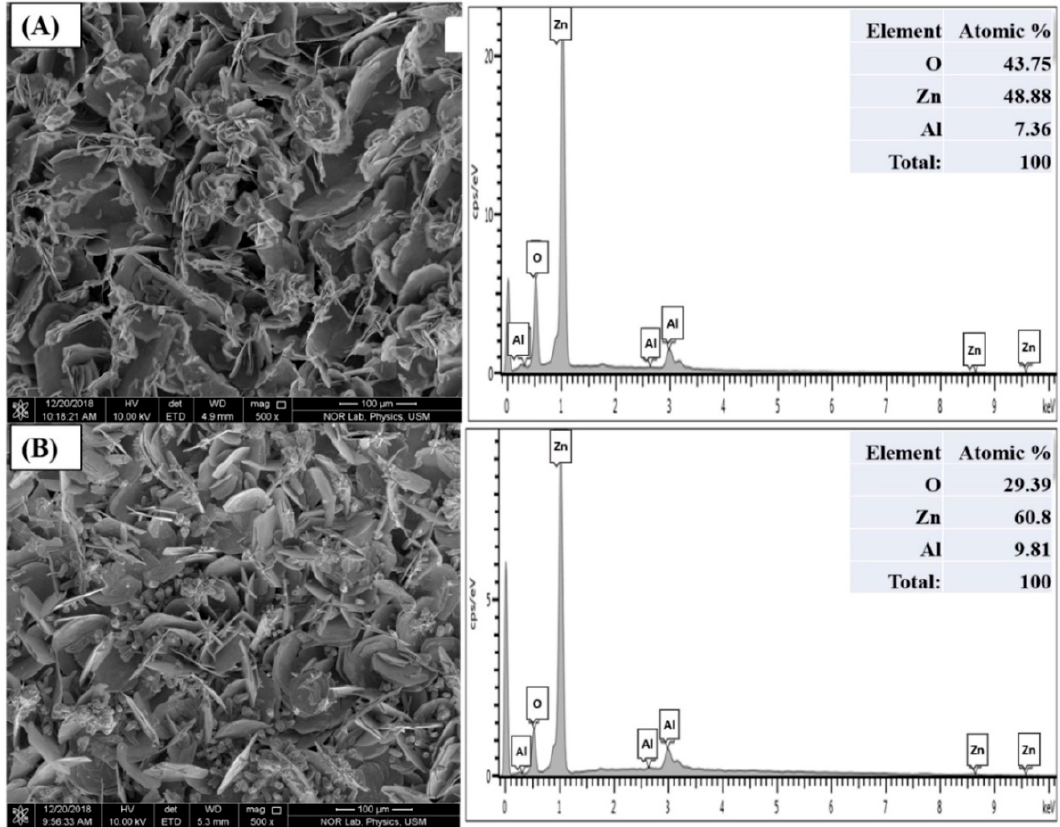
Figure 5. FESEM images with EDX of AZO for ( A ) thick film and ( B ) disk type samples.